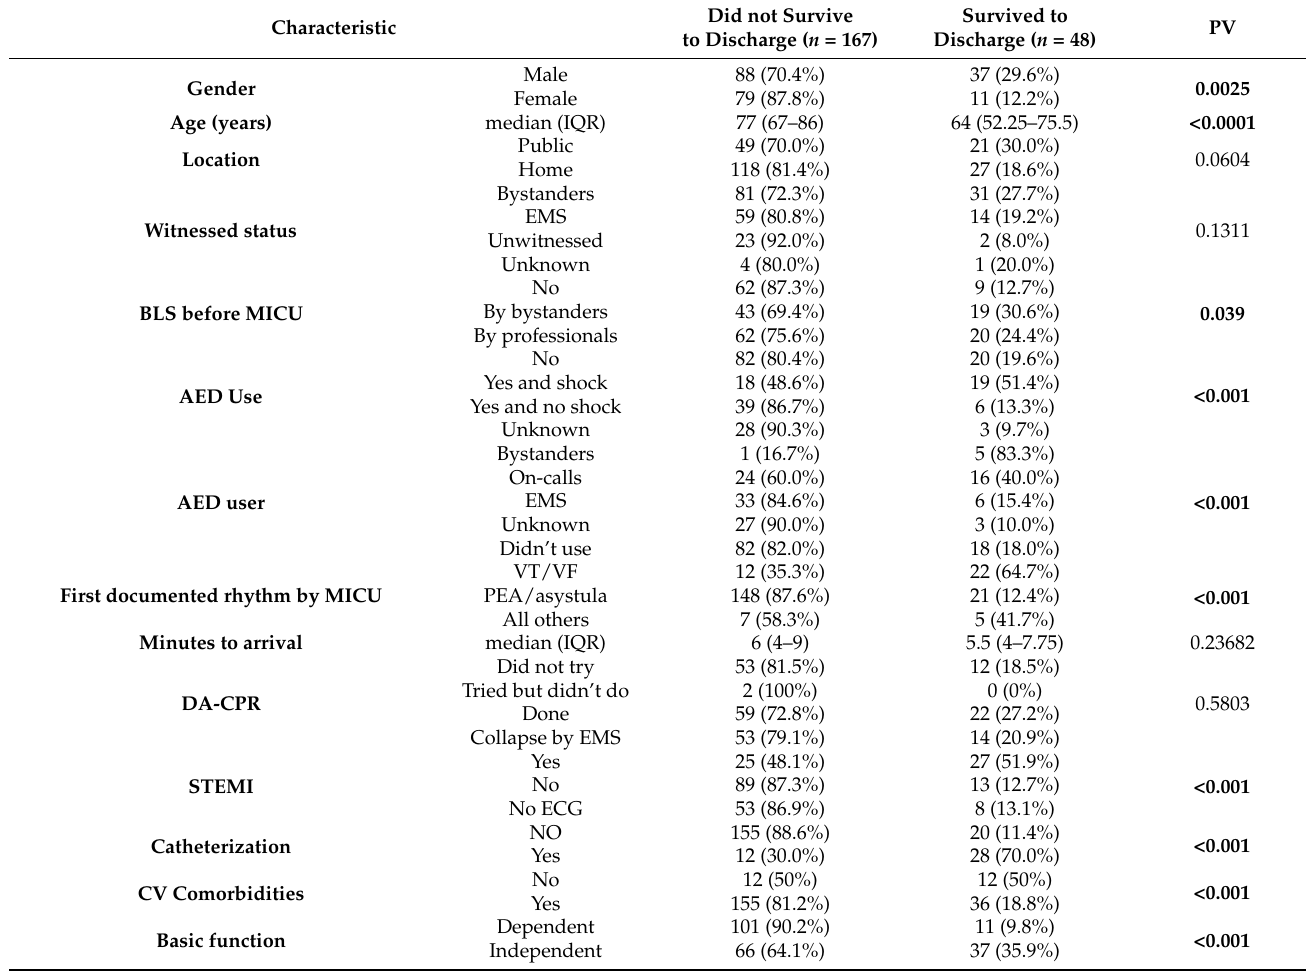
Table 3. Crude survival to discharge outcome according to patients’ characteristics and prehospital and hospital care.